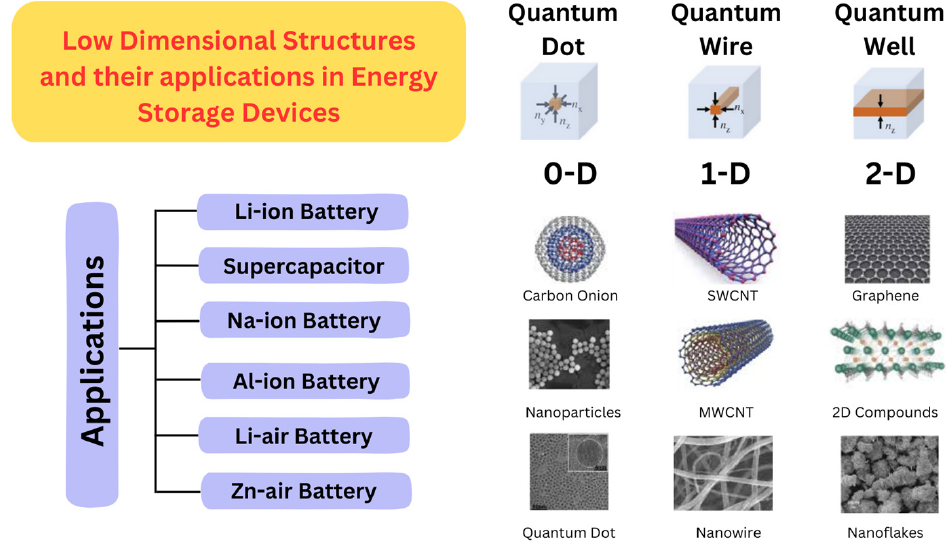
Figure 2. Low dimensional structures and their applications in energy storage